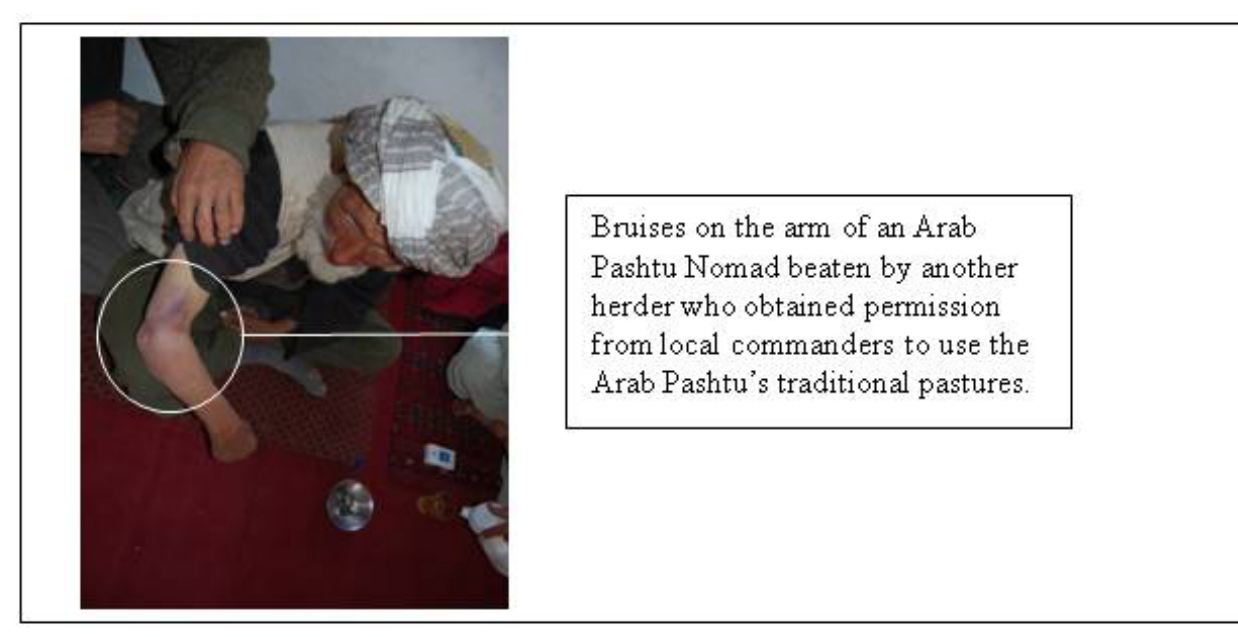
Fig. 5 . Bruises on the arm of an Arab Pashtu